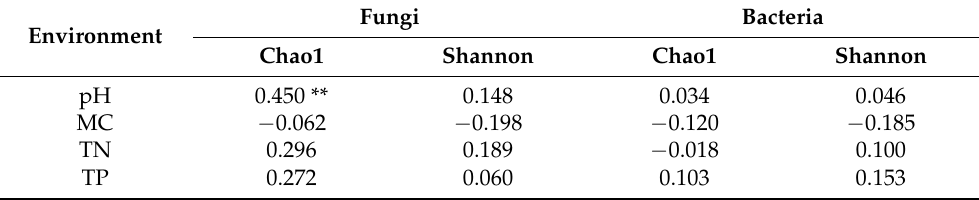
Table 3. Pearson correlation coefficients between fungal or bacterial diversity and 13 environmental factors. Fungi Environment